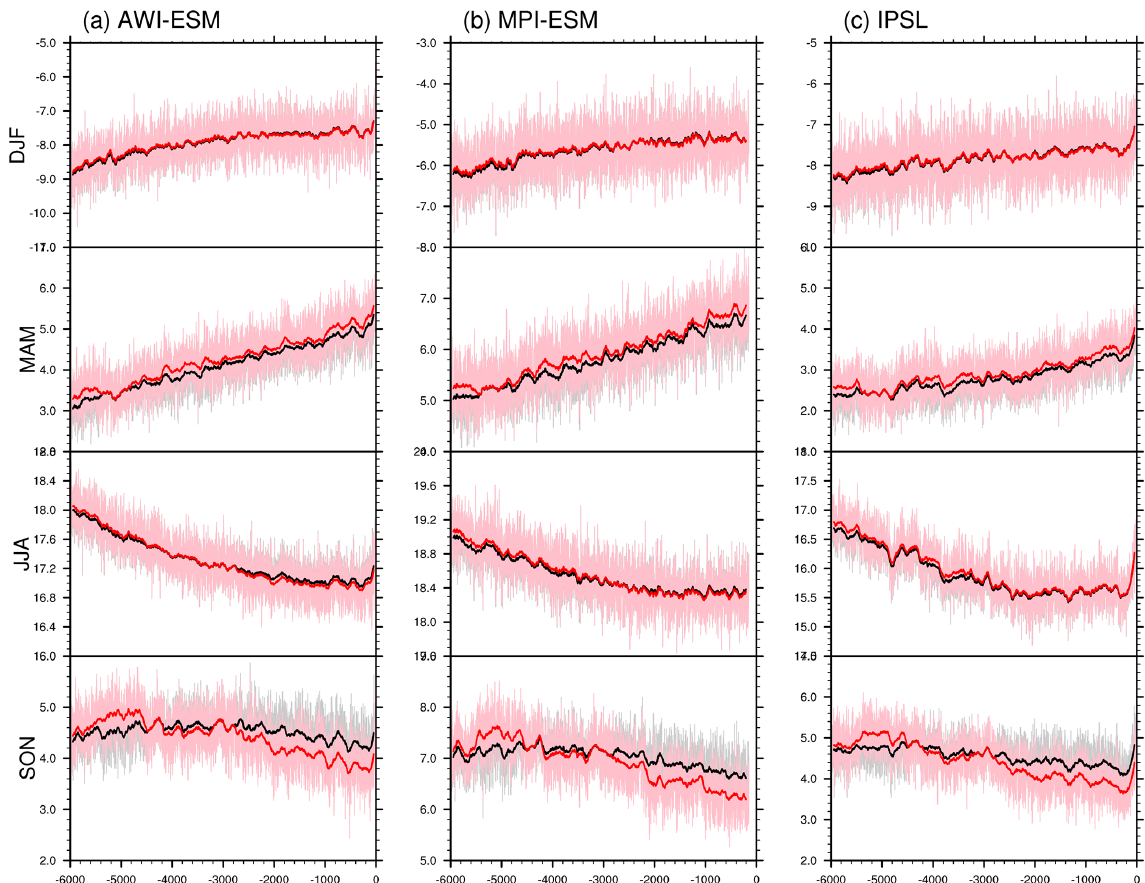
Figure 12. Time series of surface air temperature in classical and angular means averaged over Northern Hemisphere continents, weighted by month length, for (a) AWI-ESM, (b) MPI-ESM, and (c) IPSL-CM. Grey and pink lines stand for the original classical and angular means respectively. Smoothed curves with a running window of 100 model years are shown in black (for classical means) and red (for angular means). Units: ◦